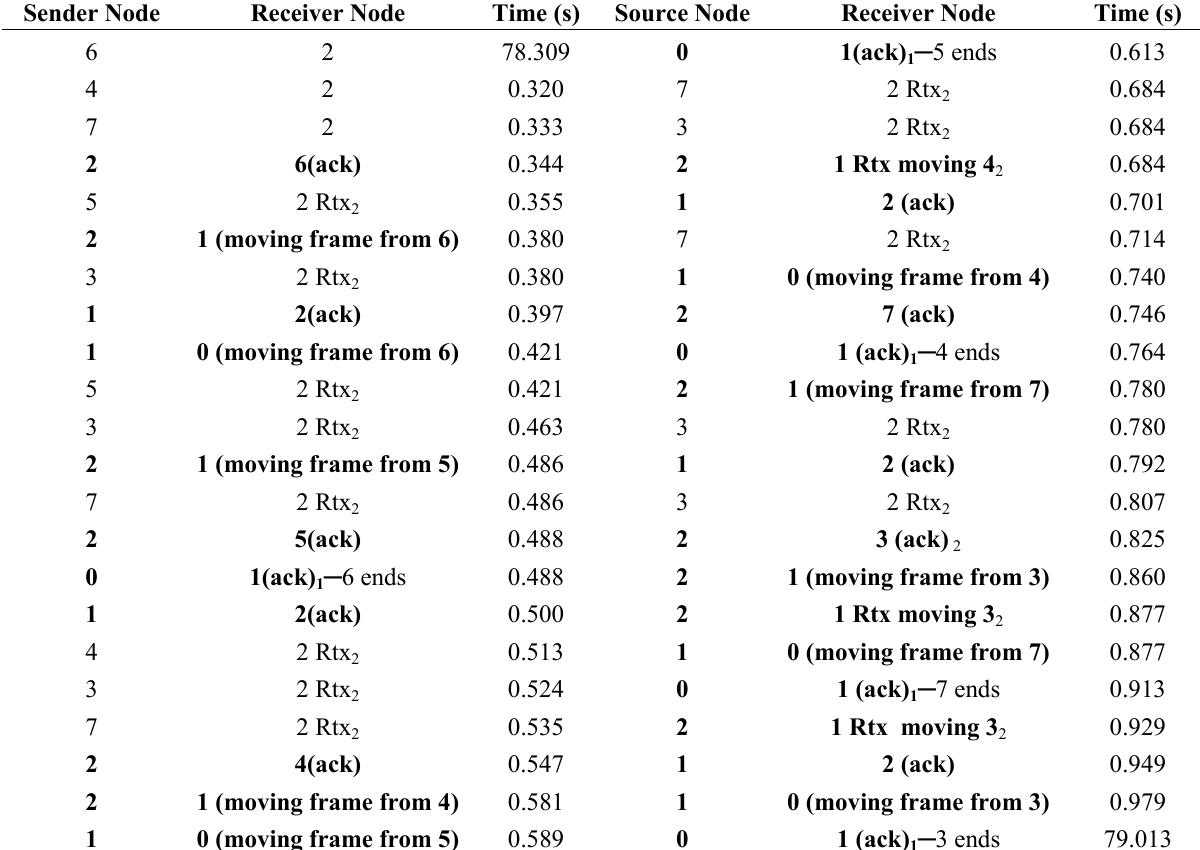
Table 4. Transmission time for 2-Bytes from all the patients to the main